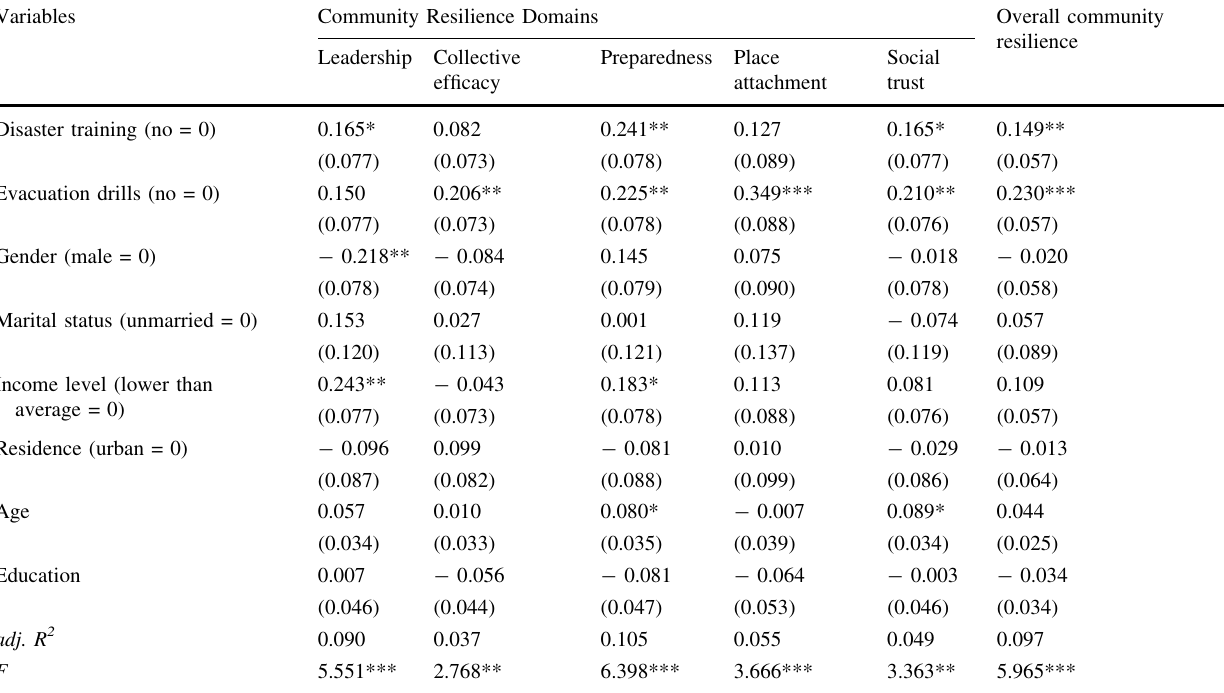
Table 5 Linear regression results for the Chinese Version of the 10-item Conjoint Community Resilience Assessment Measurement (CCRAM- 10) and its